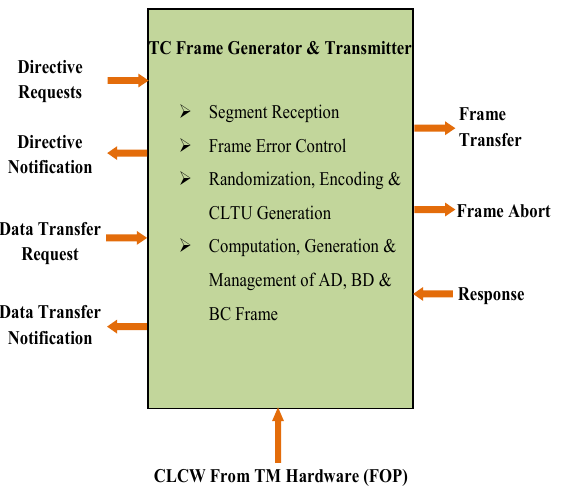
Figure 5. Interfaces of TTCP TC Frame Generator and transmitter